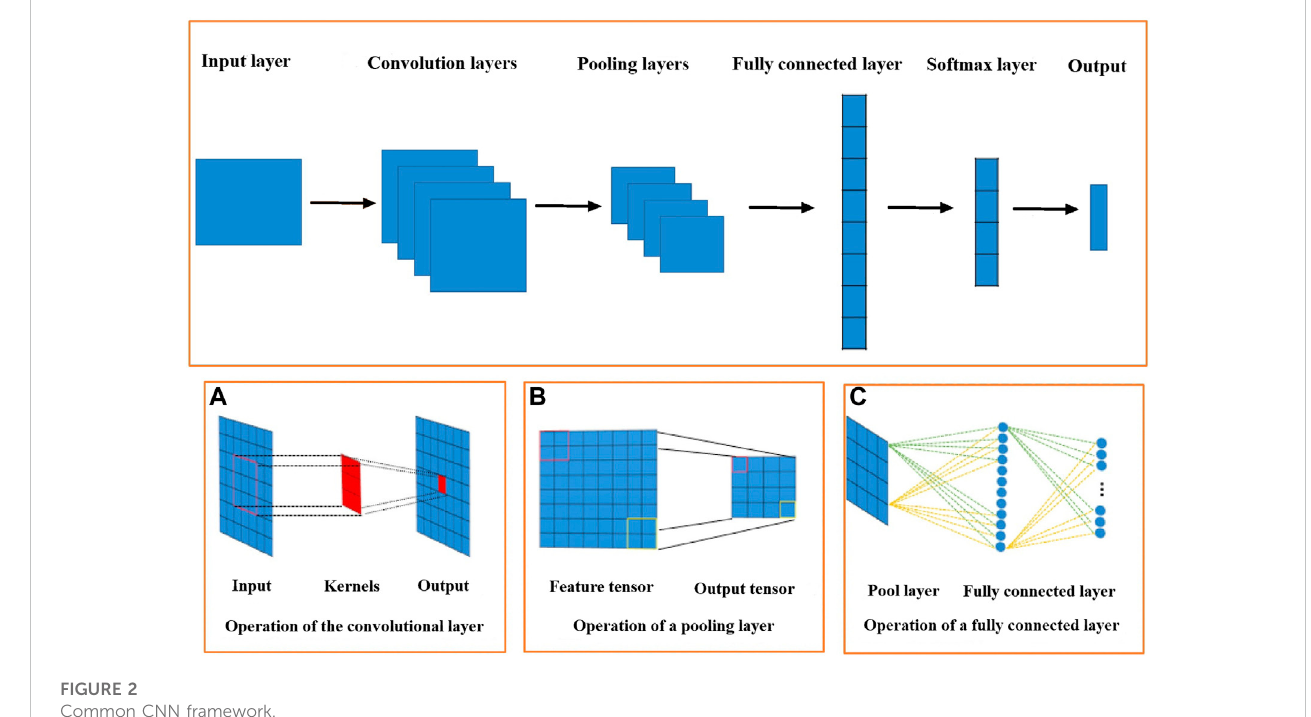
FIGURE 2 Common CNN